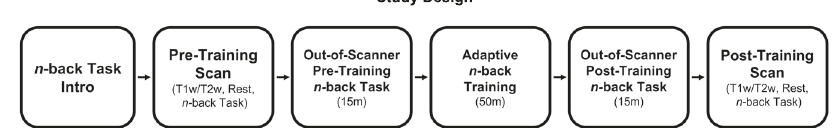
Fig. 1 Schematic of study design. The study protocol began with a fi ve-minute introduction to the n -back working memory task. Participants completed two MRI sessions consisting of structural and functional scans before and after 50 minutes of n -back training. Prior to and following the 50-min training period, participants completed a 15-min assessment to measure performance on the n -back